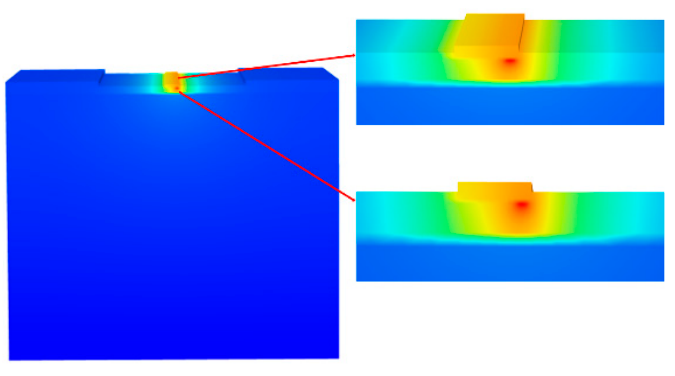
Figure 9. Temperature distribution in the HEMT grown on a SiC structure. As shown, in the AlGaN layer, the temperature is high near the gate, around the passivation layer, and along the gate. Reproduced with permission from ref. [123]. Copyright 2021 MDPI.